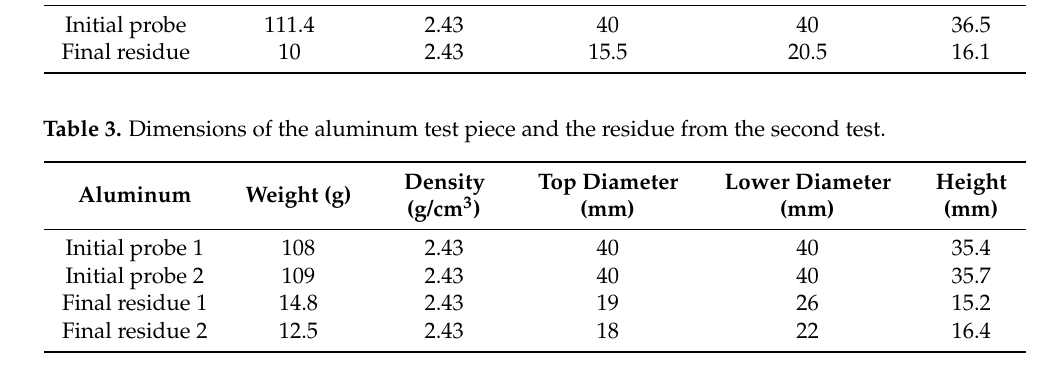
Figure 1. Initial probe of recycled aluminum and final residue.